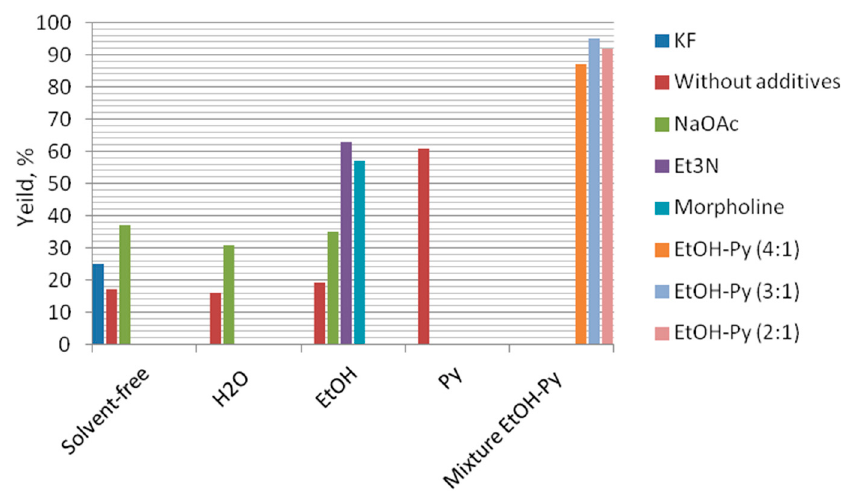
Figure 1. Comparison diagram of approaches to chromeno[2,3- b ]pyridine 4a . The mixture of EtOH-Py (3:1) provides the best result.